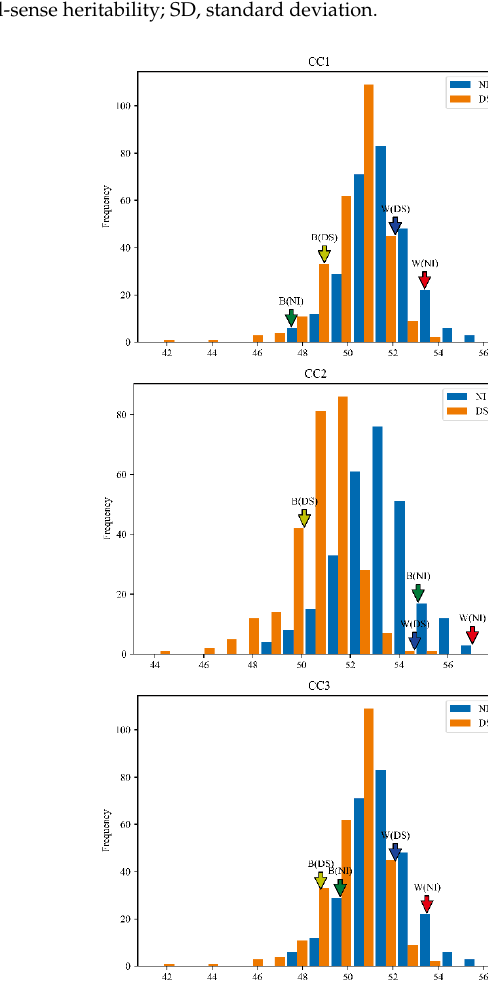
Figure 4. Frequency distribution of predicted values of LAI and CC traits in wheat RILs at three growth stages under two water treatments. W(NI) is the value of Worrakatta under normal irrigation conditions; W(DS) is the value of Worrakatta under drought stress conditions; B(NI) is the value of Berkut under normal irrigation conditions; B(DS) is the value of Berkut under drought stress conditions.